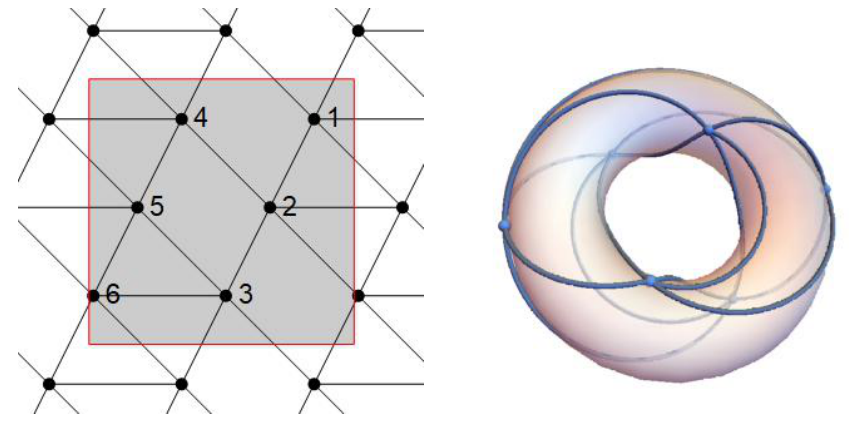
Figure 4. The drawings of K 6 on ( R /2 π Z ) 2 and R 3 .